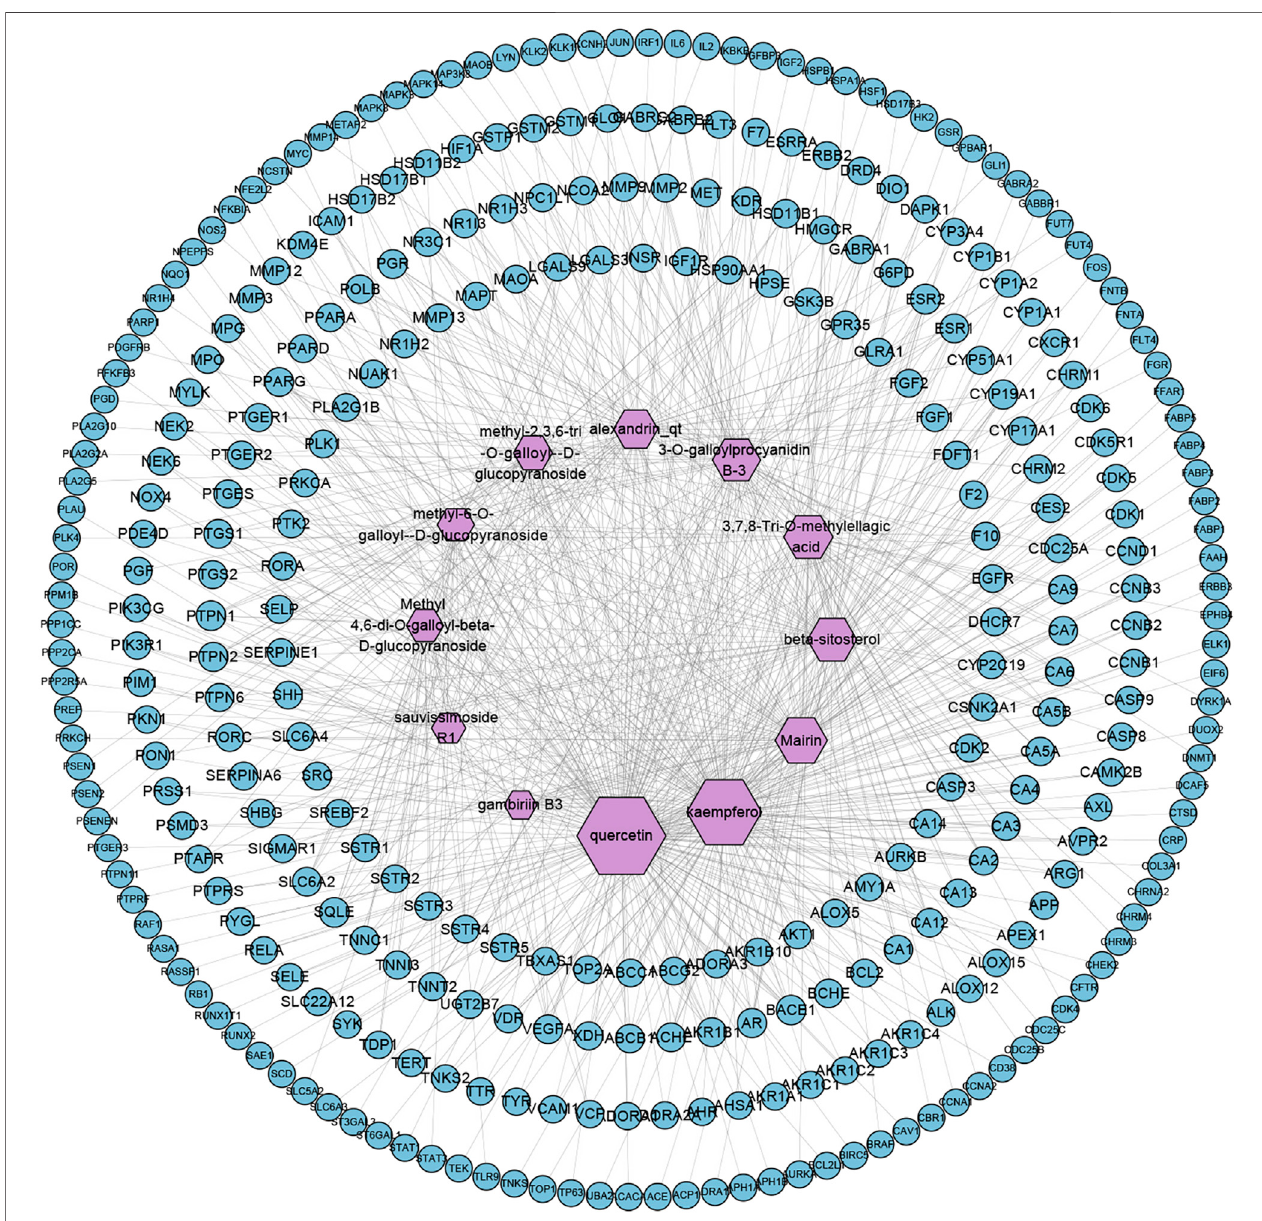
FIGURE 2 | Compound-Target network of SO (C-T network). Network of 12 active ingredients of SO and 327 putative targets. The size of compound nodes is proportional to the number of degrees.